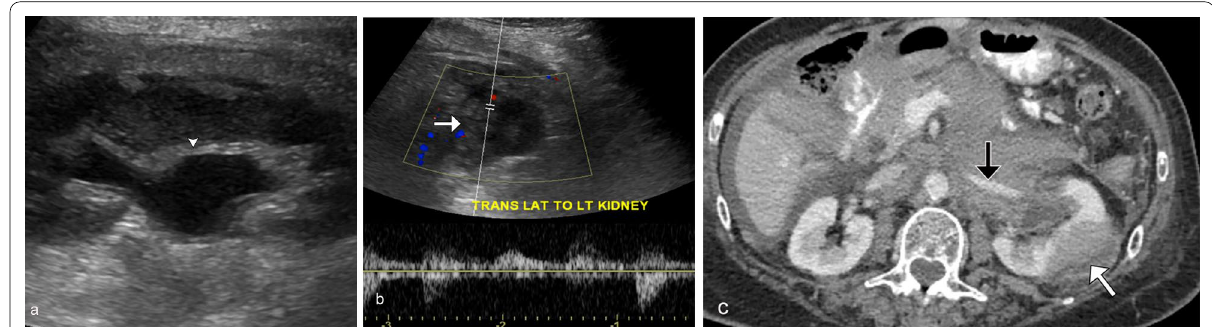
Fig. 5 Direct extension from retroperitoneal adenopathy of renal lymphoma. Grayscale ultrasound image ( a ) demonstrates mild hydronephrosis (arrowhead) of the left kidney. Spectral Doppler ultrasound ( b ) demonstrates a hypoechoic mass ( white arrow ) arising from the lateral left kidney with arterial waveform. Axial contrast CT ( c ) confirms the left renal mass ( white arrow ) with additional extensive retroperitoneal and peritoneal infiltrative disease encasing the left renal hilum. Note the maintained flow and normal caliber left renal artery ( black arrow ) despite tumor burden, characteristic of lymphoma. This patient is known to have follicular lymphoma with high grade B-cell lymphoma transformation